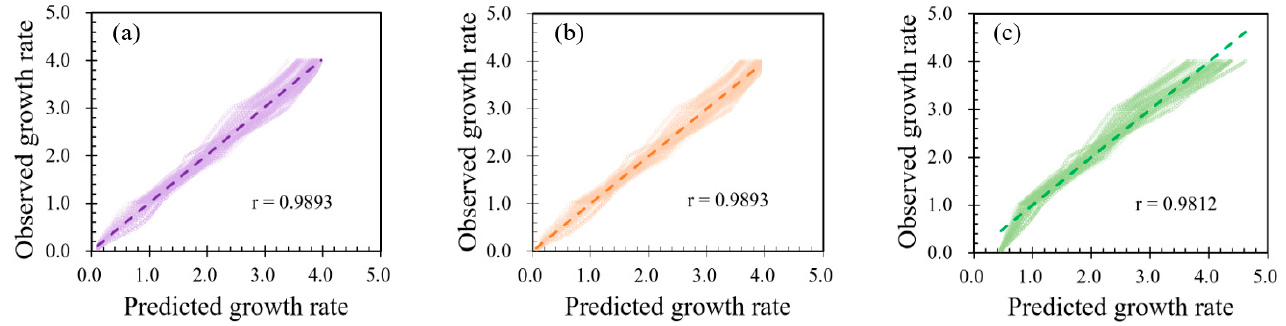
Figure 6. Modeling results for the whole growth period by three models: ( a ) ANN; ( b ) GEP; ( c ) REG. Each data point represents the observed rice growth rate (Gr) data and its related prediction of Gr. The dash-line is the least-squares regression